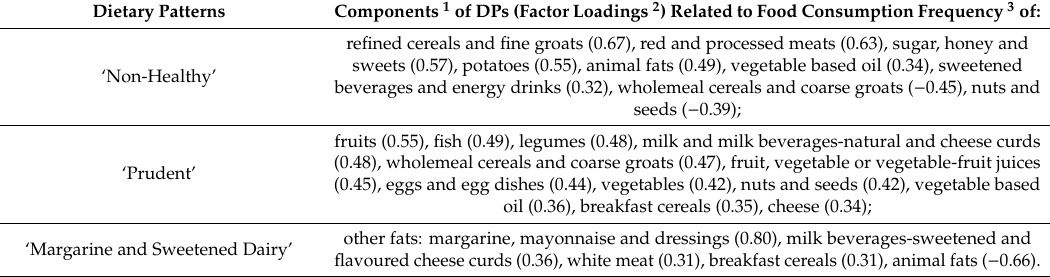
Table 3. Description of PCA-derived dietary patterns (DPs) among peri and postmenopausal women ( n = 420).